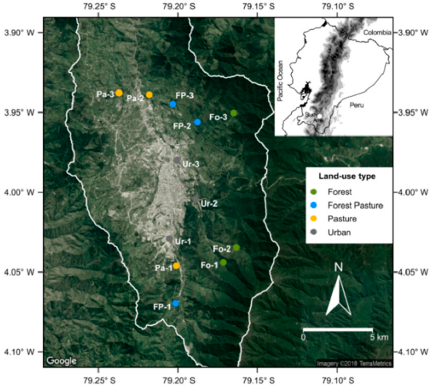
Figure 1. Location of the study area and 12 sampling sites equally distributed in four riparian land uses of Andean streams in southern Ecuador. Codes indicate the land-use intensity (Fo = forest, FP = forest-pasture, Pa = pasture, Ur =